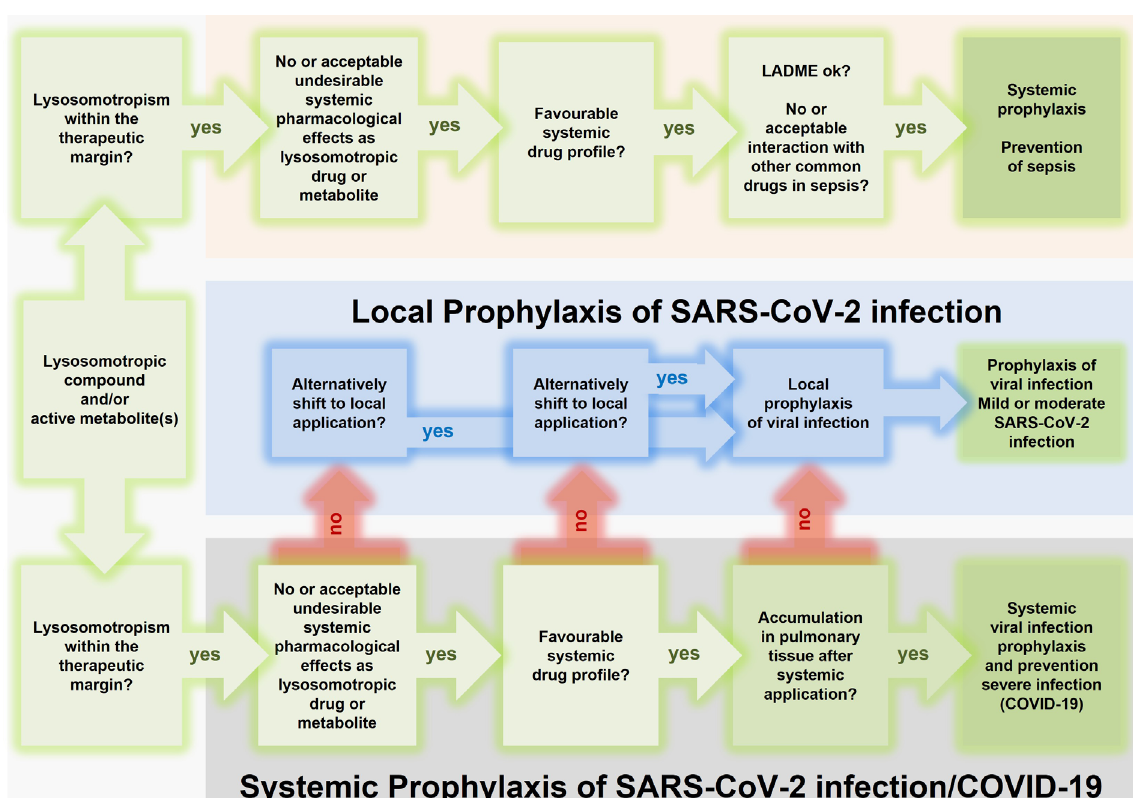
Figure 3. Rational repurposing of lysosomotropic drugs and metabolites for systemic prophylaxis of transition to sepsis and prophylaxis of (systemic) SARS-CoV-2 infection and prevention of transition to severe SARS-CoV-2 infection/COVID-19. Candidates (active compound and/or one or more of its metabolites) should meet the following criteria: weak protonatable nitrogen bases with lipophilicity (ClogP > 2) and a basic pKa between 6.5 and 11 [25, 128], lysosomotropism is present within the therapeutic margin, with or without acceptable undesirable systemic pharmacological effects as lysosomotropic drug or originating from its metabolites. Systemic prophylaxis of sepsis (top) and transition of viral infection to severe SARS-CoV-2 infection/COVID-19 (bottom) requires a favorable systemic drug profile; however, in the case of an unfavorable drug profile, in prophylaxis of viral infection local application can serve as a fallback (middle). Systemic prophylaxis of viral infection requires an accumulation in pulmonary tissue after systemic application of the